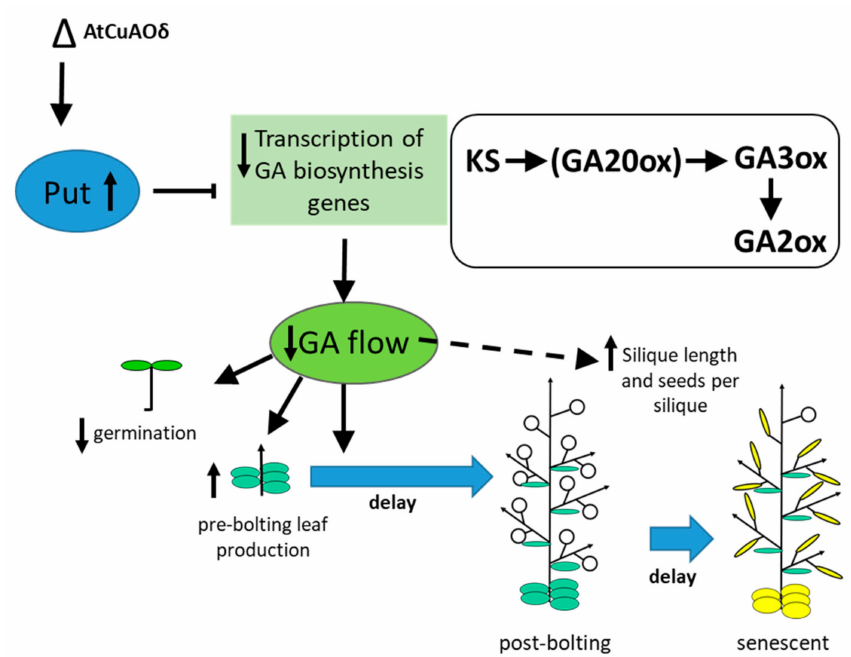
Figure 7. Diagram showing the e ff ects of AtCuAO δ mutation on plant growth regulator balance and changes in development. The loss of AtCuAO δ function results in a premature increase in Put. This in turn down-regulates the expression of GA biosynthetic genes (specifically KS , GA20ox (less so), GA2ox and GA3ox ) resulting in a reduction of the flow through the gibberellin pathway. This results in a delay in germination and bolting (black arrows). Delayed seed production results in delayed rosette senescence. E ff ects on silique length and number of seeds per silique may be directly mediated by the reduction in GAs or may occur via a di ff erent